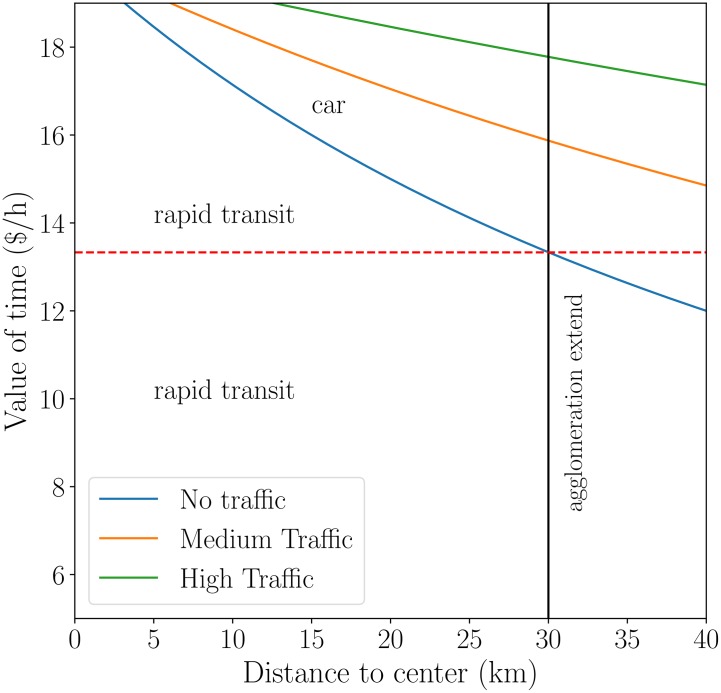
The most advantageous mode of transport depends on the value of time of individuals and the distance to the urban center.The limit between the two areas evolves with congestion: the larger the traffic (curves from blue to green) and the larger the area in which rapid transit is beneficial compared to car driving. The grey solid vertical line corresponds to the size of the urban area and indicates the critical value of time (dashed red line) below which rapid transit is advantageous in the whole agglomeration whatever the value of congestion. The values of the parameters are chosen here as: Cc = 15 $, vc = 40 km/h, vm = 30 km/h, f = 30 minutes (see Material and methods for a precise description of all data).